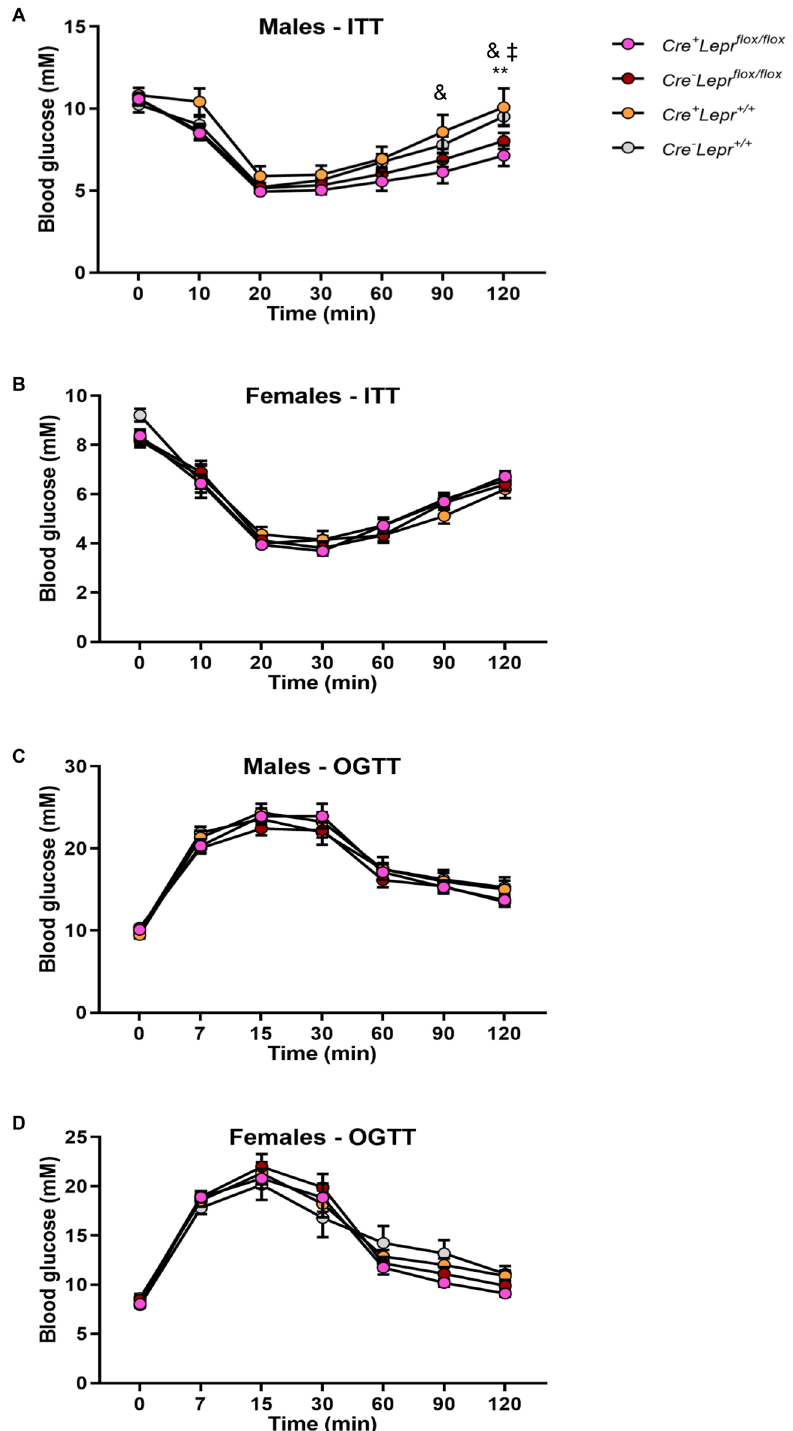
Figure 9. Insulin tolerance tests (ITTs) ( A , B ) and oral glucose tolerance tests (OGTTs) ( C , D ) in mice from the Lepr knockdown study. In ( A ), n = 18 for Cre + Lepr flox/flox , n = 20 for Cre − Lepr flox/flox , n = 12 for Cre + Lepr + / + , and n = 13 for Cre − Lepr + / + . In ( B ), n = 20 for Cre + Lepr flox/flox , n = 17 for Cre − Lepr flox/flox , n = 9 for Cre + Lepr + / + , and n = 8 for Cre − Lepr + / + . In ( C ), n = 15 for Cre + Lepr flox/flox , n = 18 for Cre − Lepr flox/flox , n = 11 for Cre + Lepr + / + , and n = 12 for Cre − Lepr + / + . In ( D ), n = 20 for Cre + Lepr flox/flox , n = 16 for Cre − Lepr flox/flox , n = 9 for Cre + Lepr + / + , and n = 8 for Cre − Lepr + / + . Performed repeated measures two-way ANOVA with post-hoc analysis. ‡ p < 0.05, Cre − Lepr flox/flox vs. Cre + Lepr + / + ; & p < 0.05, Cre + Lepr flox/flox vs. Cre + Lepr + / + ; **p < 0.05, Cre + Lepr flox/flox vs. Cre − Lepr + / + . Main effect of time (p < 0.05) in ( A – D